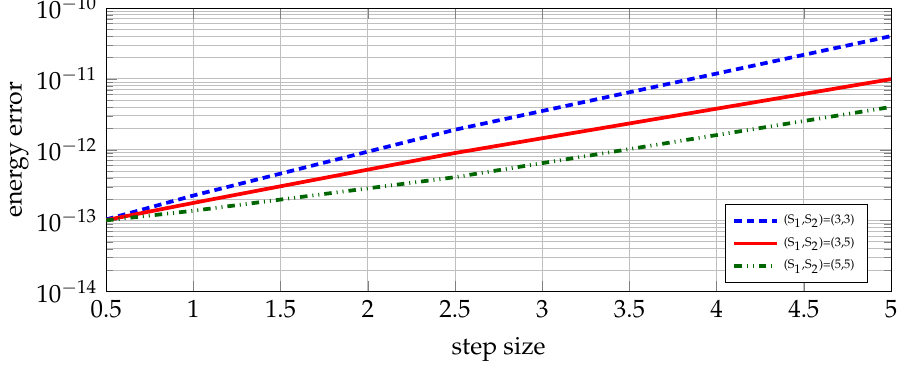
Figure 5. Solar system. Global error for the energy error using the proposed family of exponential methods for S 1 = 3, S 2 = 5 (red line), S 1 = 5, S 2 = 5 (green line) and the ones that use S 1 = S 2 = 3 (blue